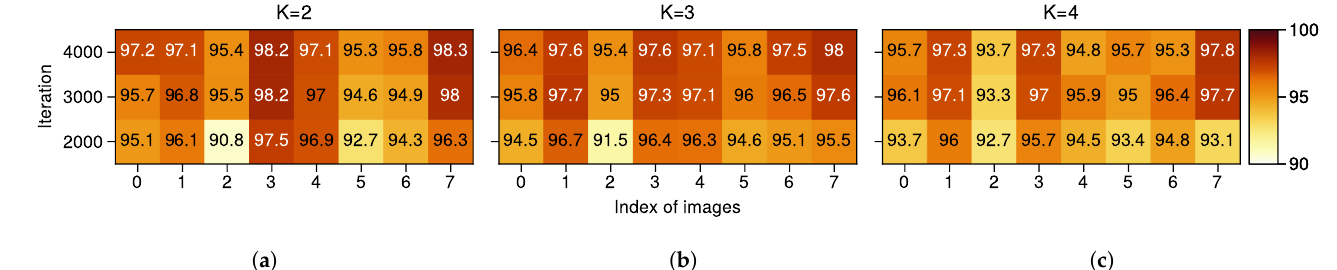
Figure 12. Averaged quality (%) of correct pseudo-labels with different K on POT → VAI, calculated from the same images in Figure 8. ( a ) K = 2. ( b ) K = 3. ( c ) K =